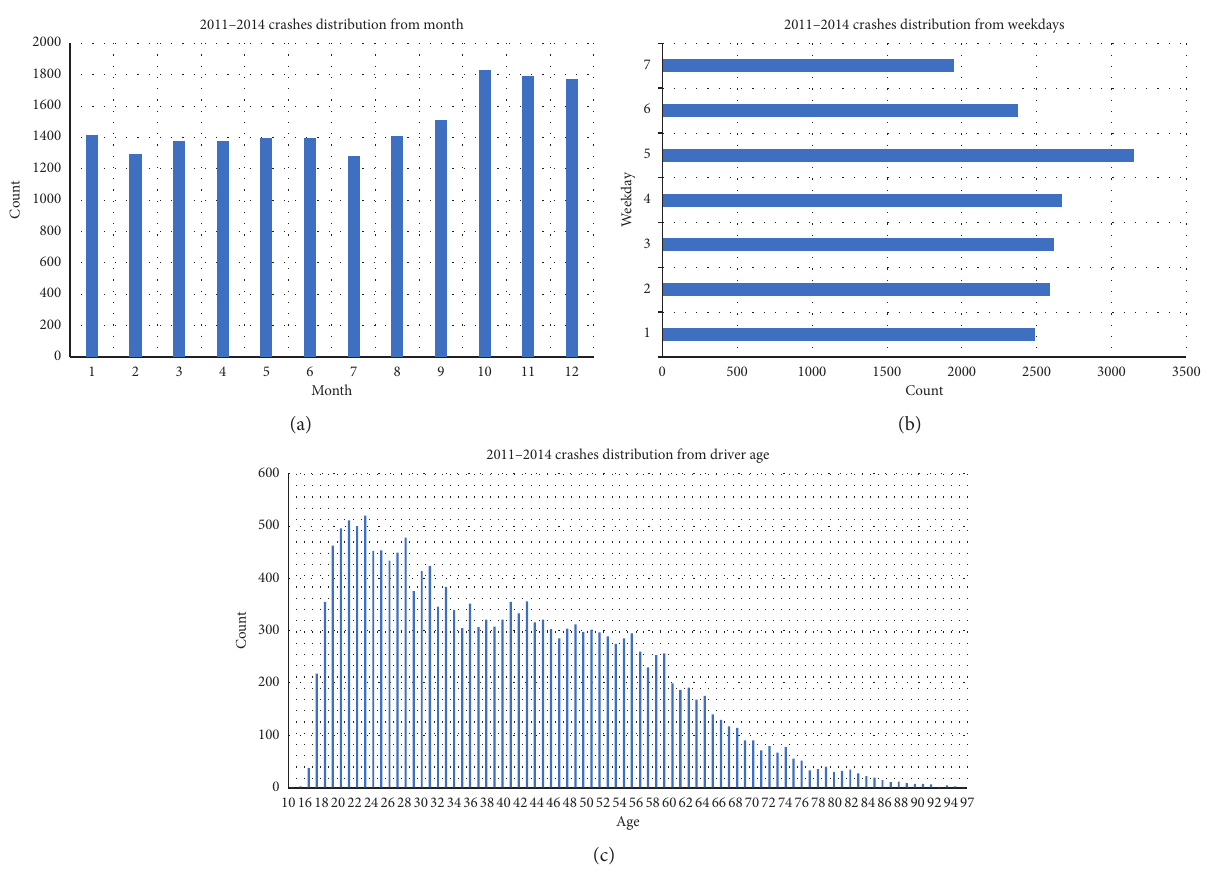
Figure 2: Crash distribution based on a (a) month, (b) weekday, and (c) driver age for 2011–2014. Table 1: Summary of the selected